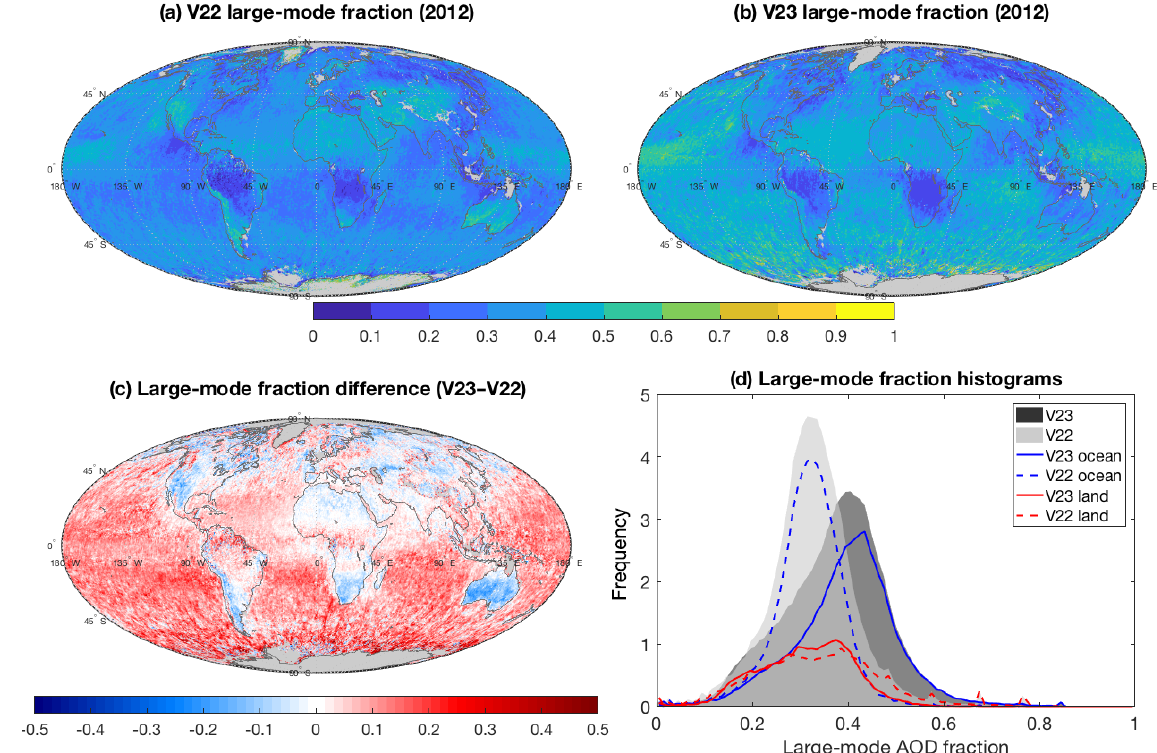
Figure 14. As in Fig. 7 except for the MISR-retrieved large-mode AOD fraction. AOD weighting is applied in data